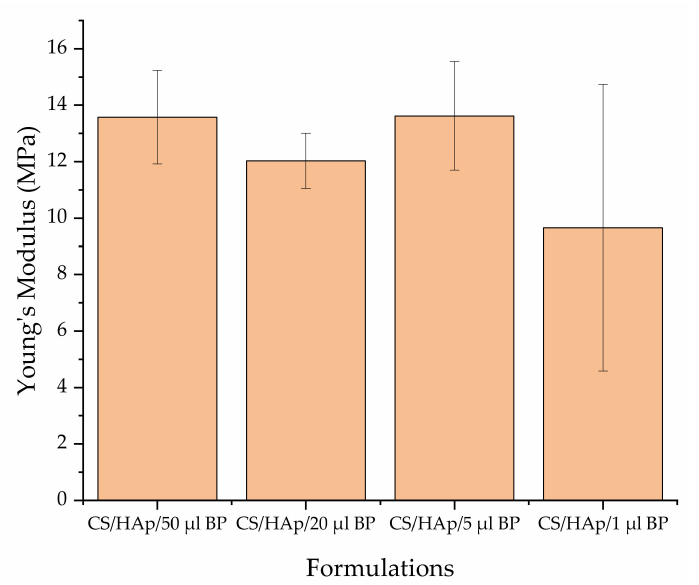
Figure 6. The Young’s modulus values of the chitosan scaffolds with different BP contents present the lowest strength in the least BP